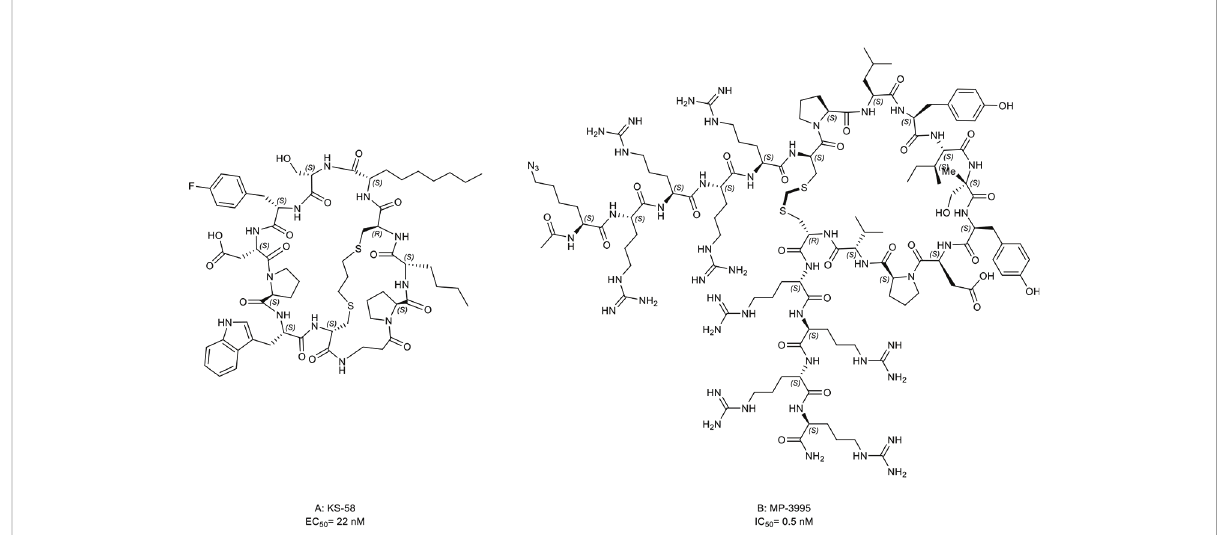
FIGURE 9 Macrocyclic peptides targeting KRAS. (A) KS-58, EC50= 22 nM; (B) MP-3995, IC50= 0.5